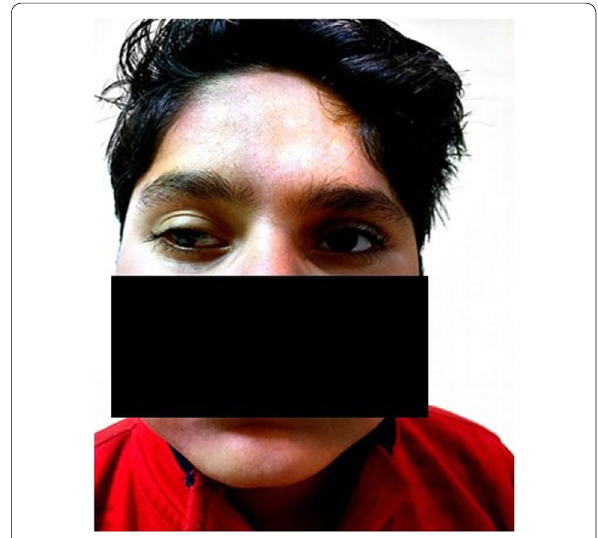
Fig. 1 Patient photograph showing right eyelid ptosis with abduction to the right side